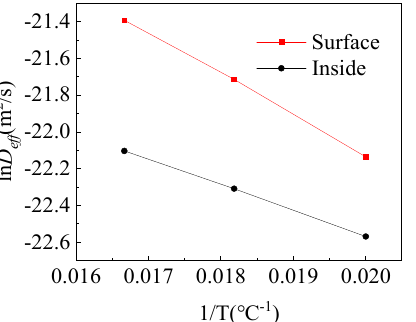
( b ) Interior Figure 12. The variation in effective moisture diffusivity with moisture content at different temper- atures. ( a ) The heaped tobacco strips’ surface ; ( b ) the heaped tobacco strips’ interior. In other fields, the influence of temperature on effective moisture diffusivity has been studied [34,35]. The logarithm was taken based on Equation (20), and written as Equation (23):